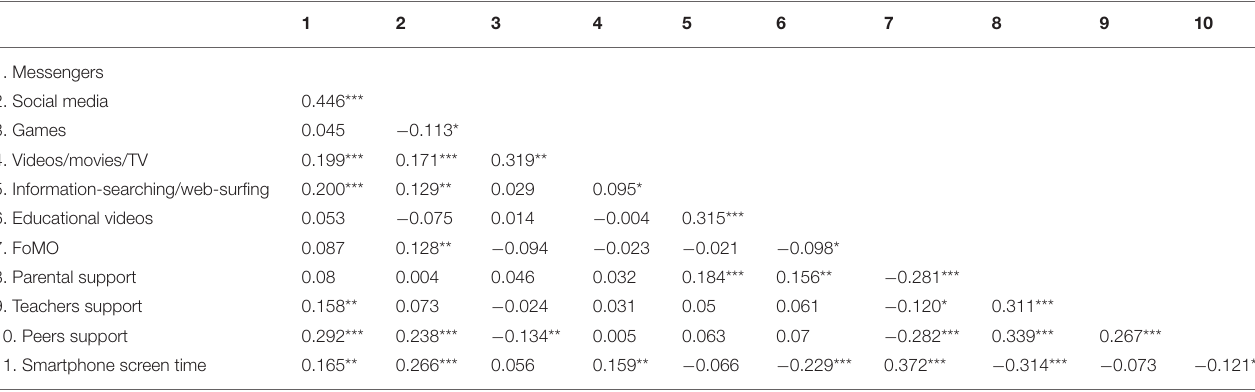
TABLE 3 | Correlation among intrapersonal, interpersonal factors, and smartphone screen time ( N = 428).